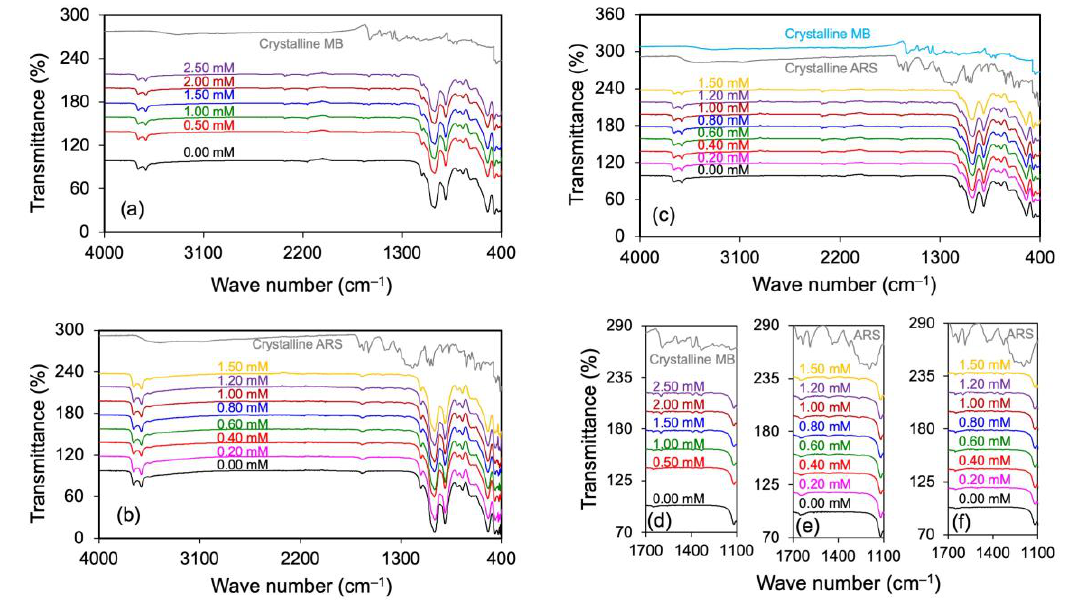
Figure 6. FTIR spectra of the HNC after MB ( a ) and ARS ( b ) sorption from a single solution of different initial concentrations and a mixed solution of different initial concentrations ( c ) and their enlargement at 1100 to 1700 cm −1 ( d – f ). Both dyes have the same initial concentration as indicated by the numbers.